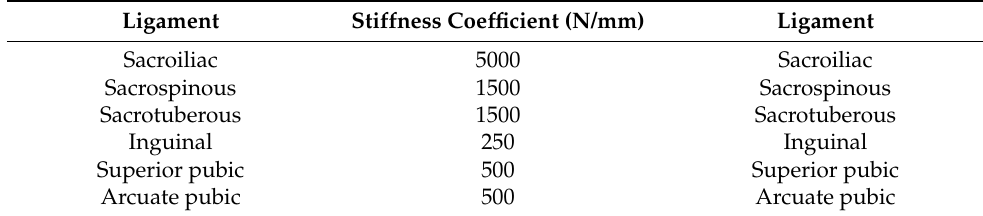
Table 2. Main ligament parameters of the pelvis. Ligament Stiffness Ligament